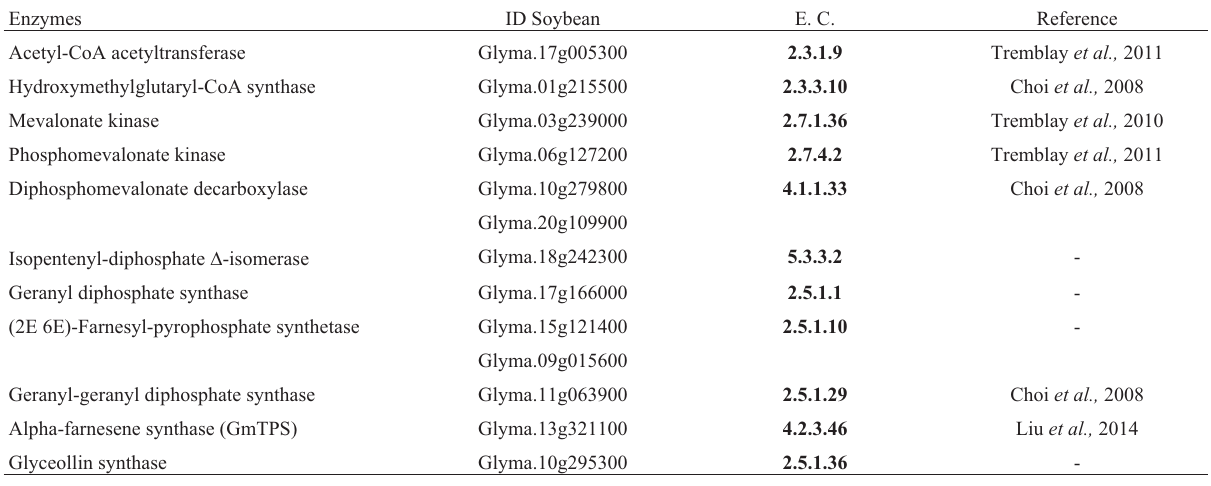
Table 1 - List of enzymes from the mevalonate pathway identified in KEGG and the corresponding gene models obtained from Phytozome V12.0. Enzymes ID Soybean